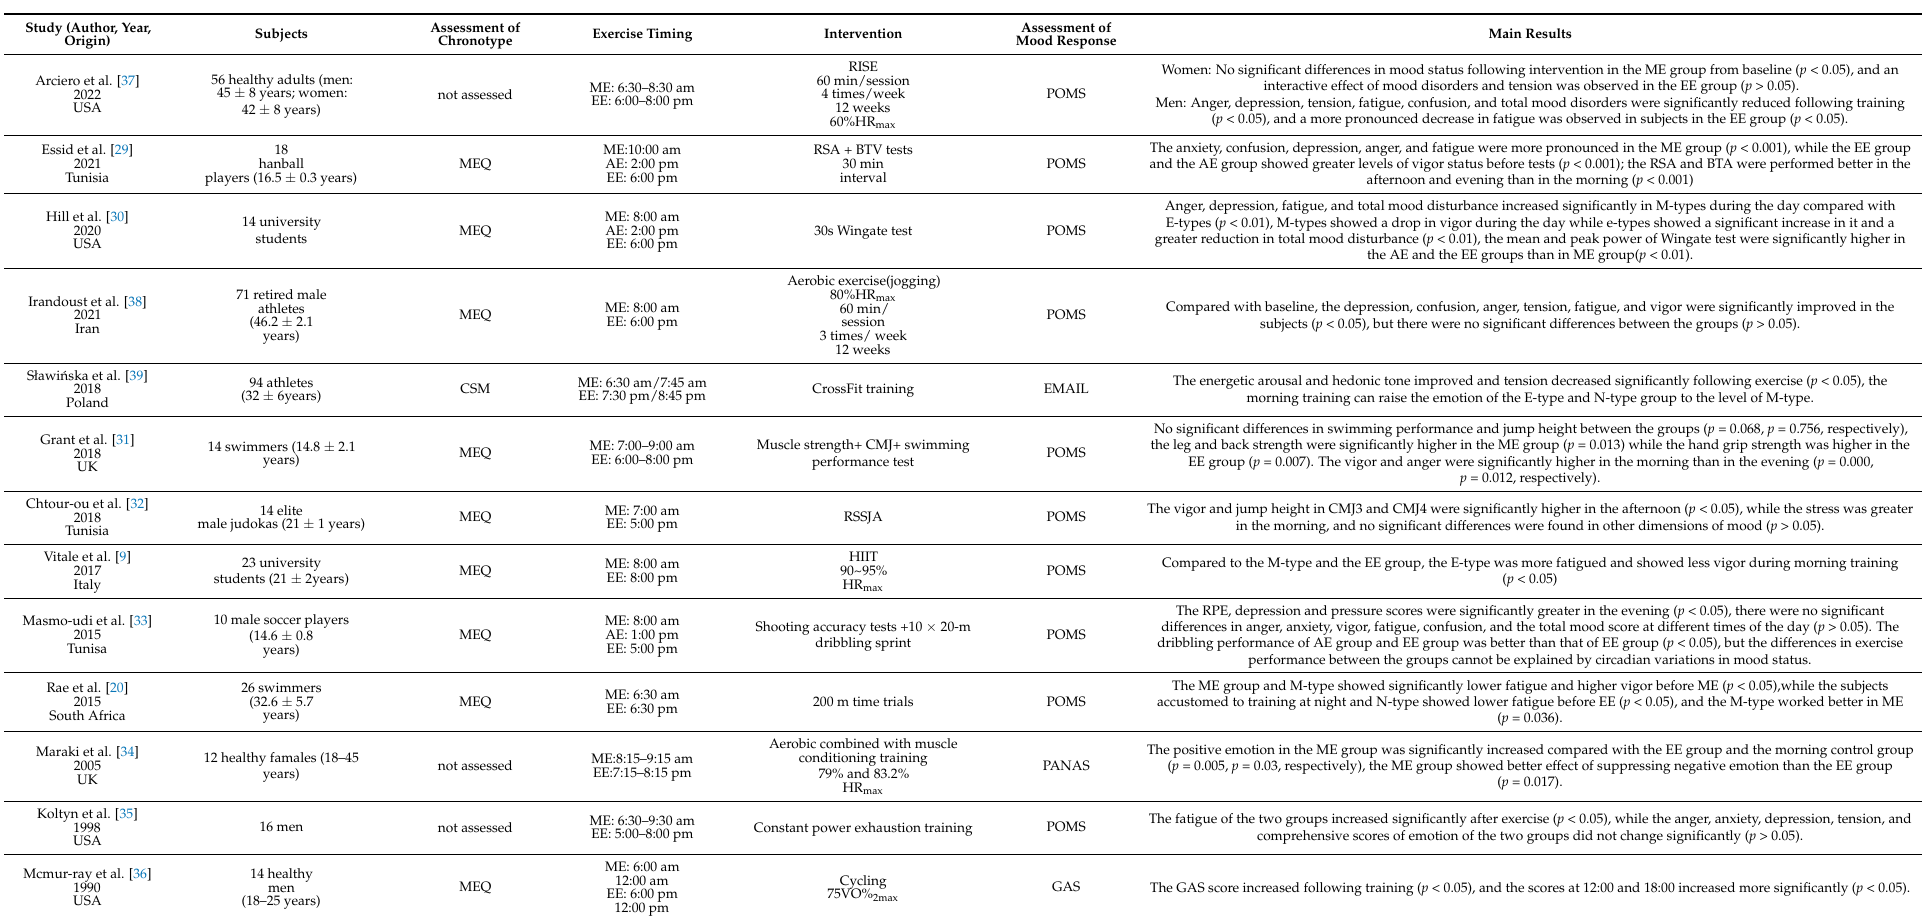
Table 2. The relationship between chronobiology and sports psychology.